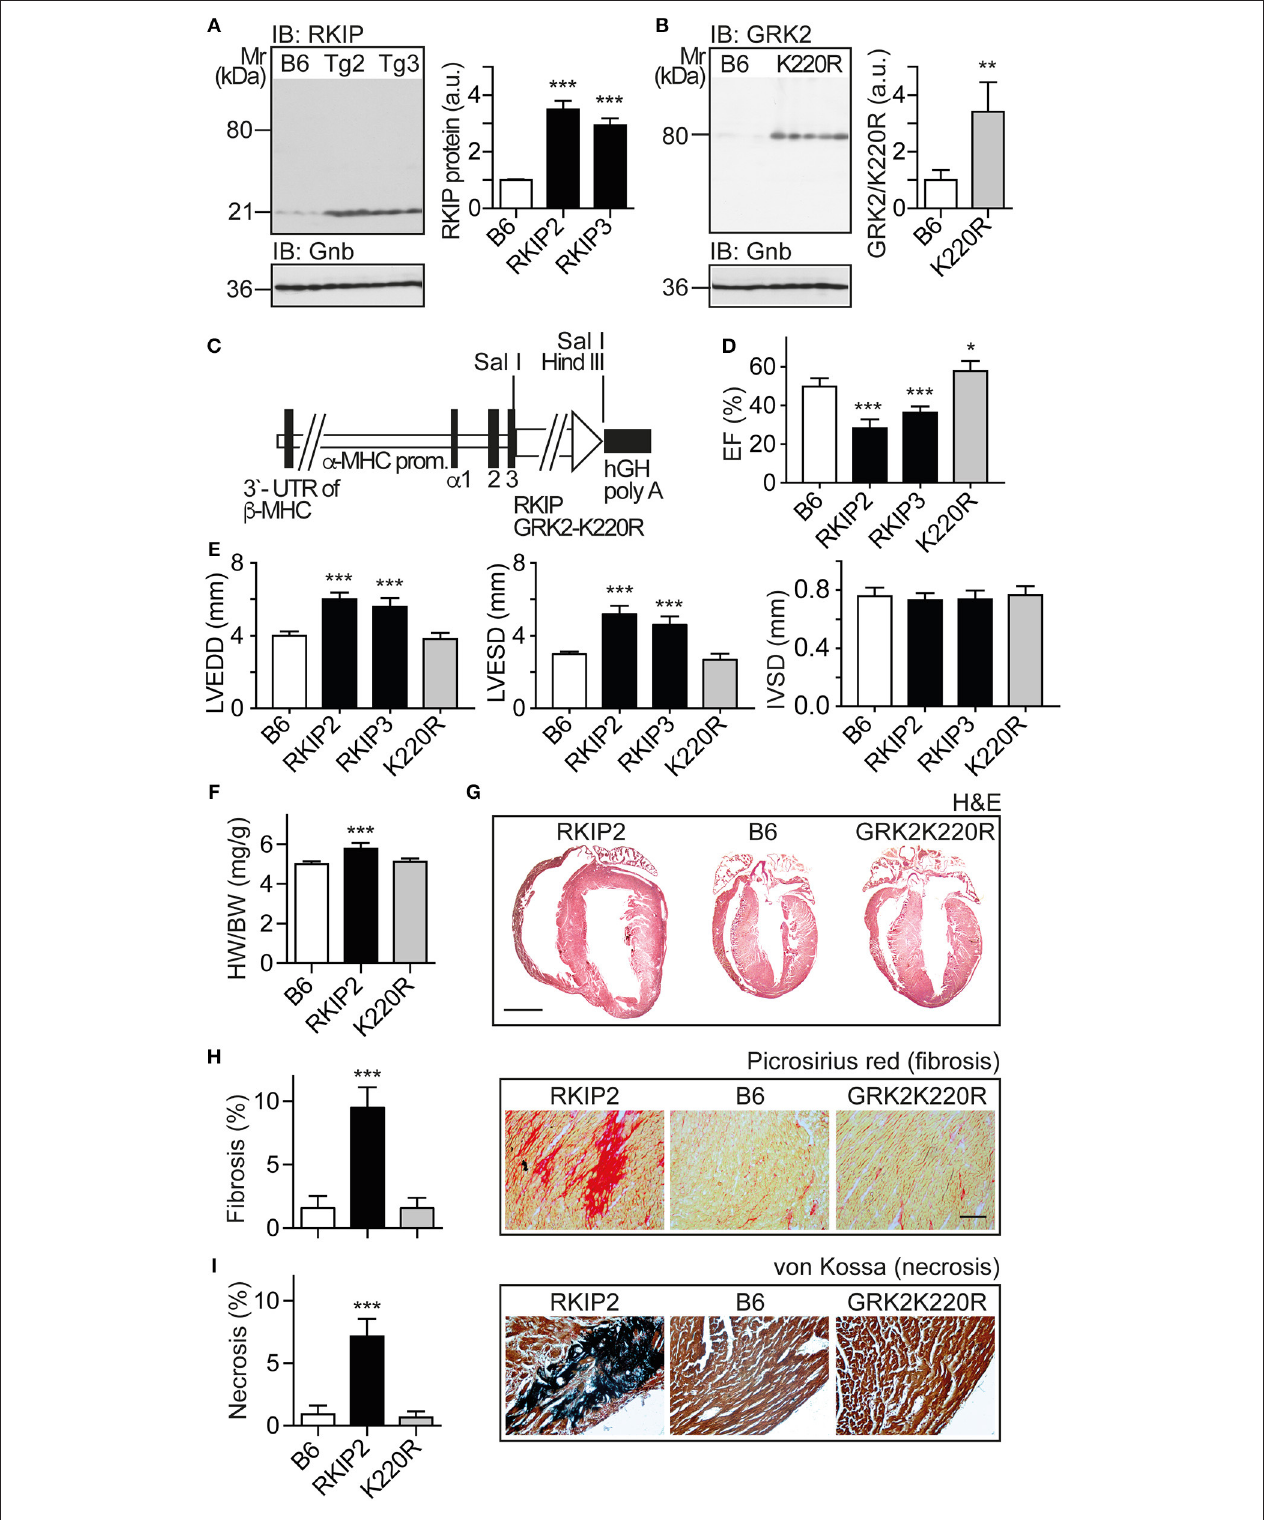
FIGURE 3 | Myocardium-specific expression of RKIP induces cardiac dysfunction whereas GRK2-K220R improves cardiac function. (A) Immunoblot detection of RKIP in non-transgenic B6 and two different Tg-RKIP mouse lines, Tg-RKIP2 and Tg-RKIP3 ( ± s.d.; n = 3; *** p < 0.001 vs. B6; Dunnett’s test). (B)